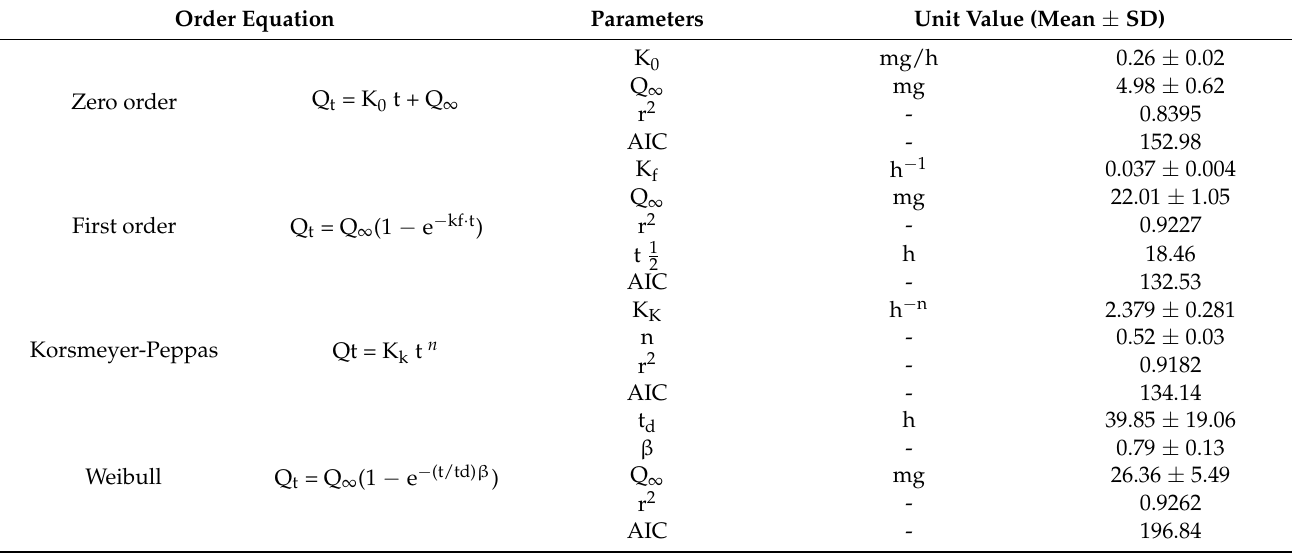
Table 2. In vitro release profile. Average parameters obtained after fitting the drug release data to different equations of the kinetic model. (The data were obtained from the mean of three experiments, n = 3).